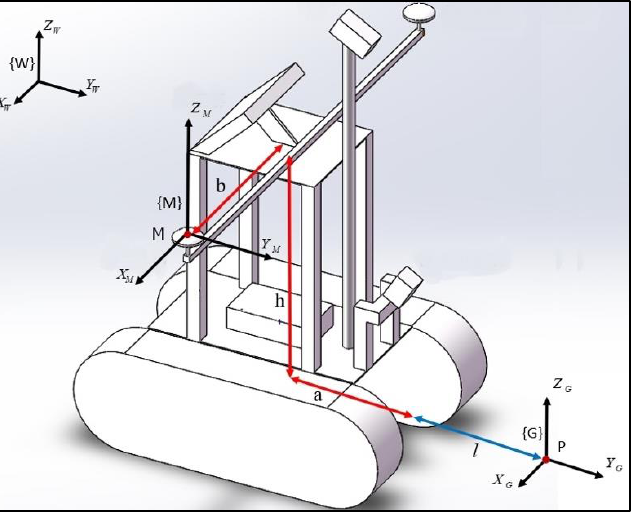
Figure 5. Preview point generation in 3D space.